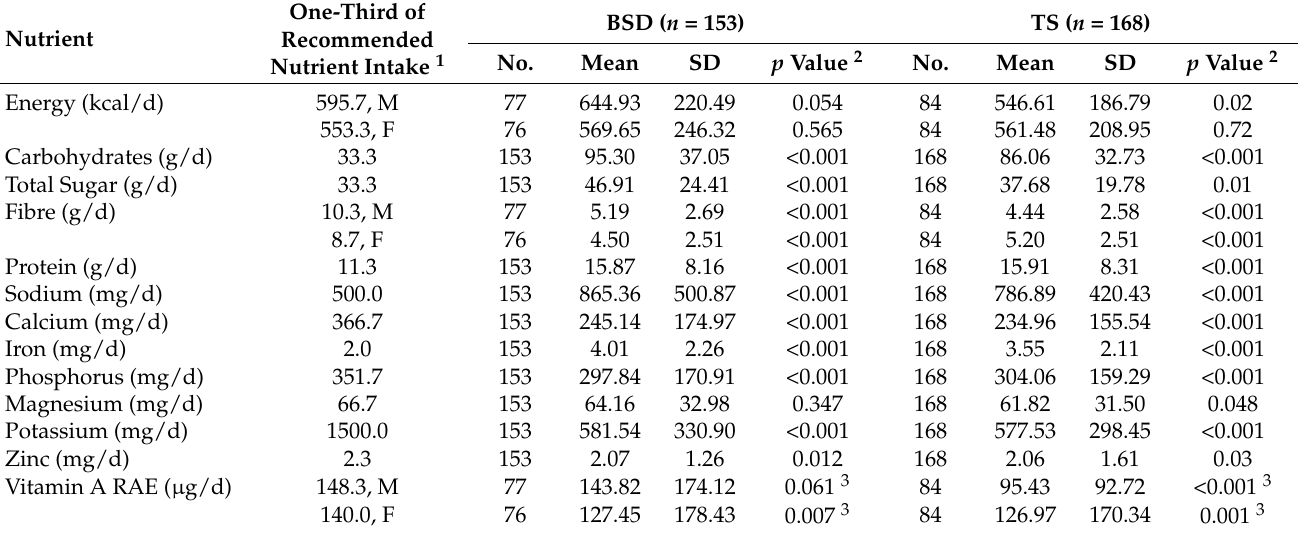
Table 5. Comparison of mean intake in each school schedule to one-third of